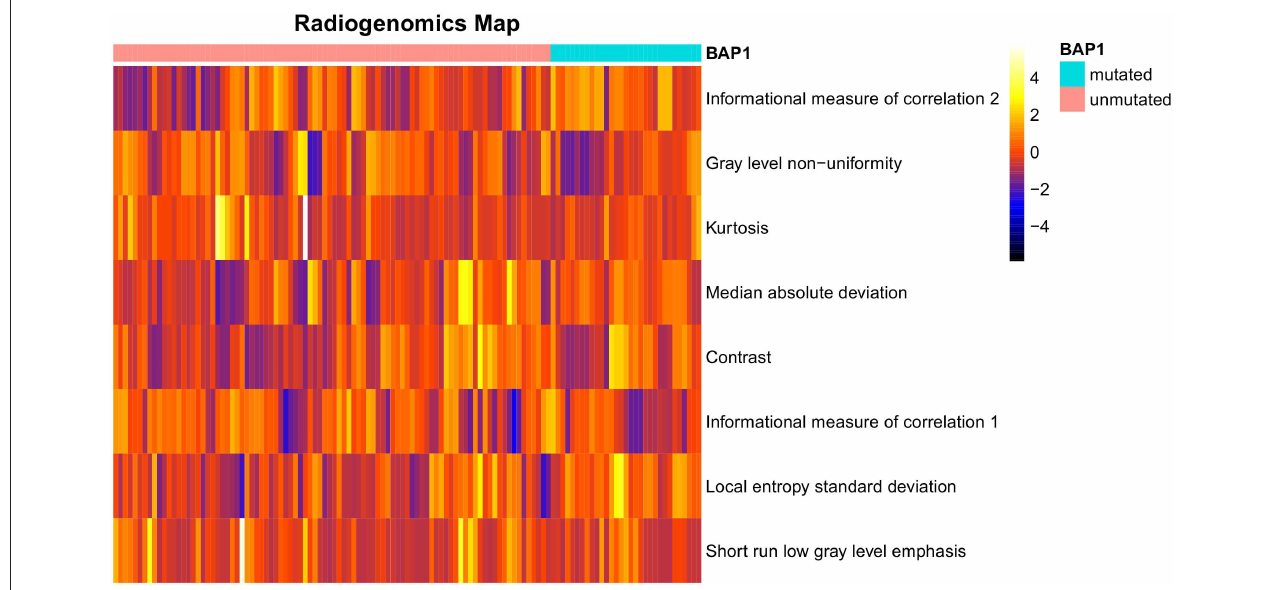
FIGURE 2 | Radiogenomics map of selected features per mutation in the radiogenomics cohort. Each row represented a feature and each column represented a segmentation. The difference of each feature between BAP1 mutated and unmutated can be